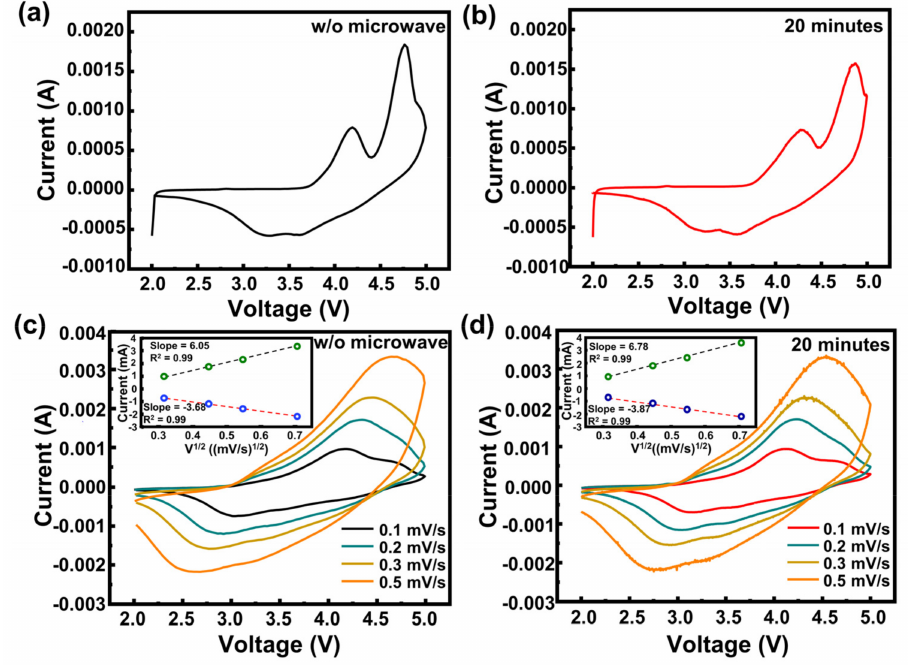
Figure 5. First-cycle cyclic voltammogram of LNCM samples ( a ) without microwave treatment and ( b ) with 20 min of microwave treatment. Cyclic voltammograms of LNCM samples ( c ) without microwave treatment and ( d ) with 20 min of microwave treatment measured at different scan rates (the inset shows the relationship between the peak current ( I p ) and the square of the scan rate ( v 1/2 )). By comparing the second peak to the first peak (I(4.7 V)/I(4.2 V)), the